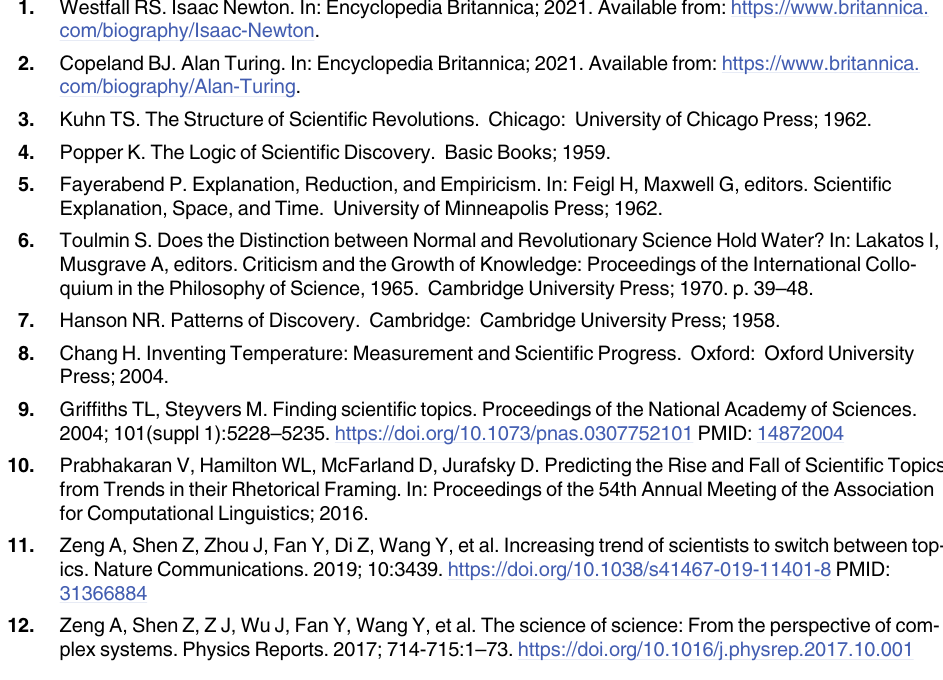
S2 Table. Percentage breakdowns from winner-take-all analyses. Tthe percentage break- downs from the winner-take-all analyses described in the main text for the group of award- winning scientists as well as randomly-sampled scientists. The percentage of the model with the highest winning percentage across scientists within each scientific field is marked in